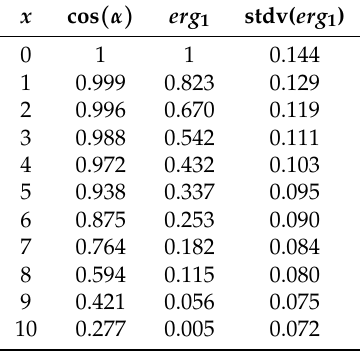
Table 1. Reconstruction precision of the factor with dominant variance between participants and its corresponding ergodicity value. The value x gives the degree to which the data is ergodic, with x = 0 indicating strong differences between and within participants and x = 10 indicating a perfectly ergodic situation. The angle α is the angle between the true first factor and the reconstructed factor; a cosine of one means perfect reconstruction, a cosine of 0 means orthogonal vectors. x